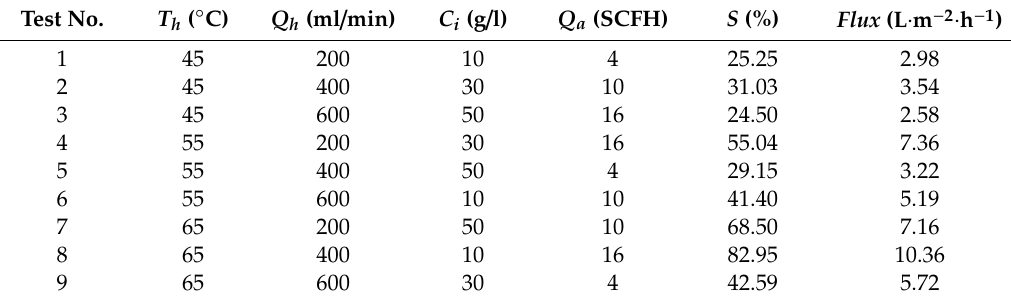
Table 3. Operating variables and their levels based on the Taguchi L 9 orthogonal array, as well as the corresponding permeate flux for each test.